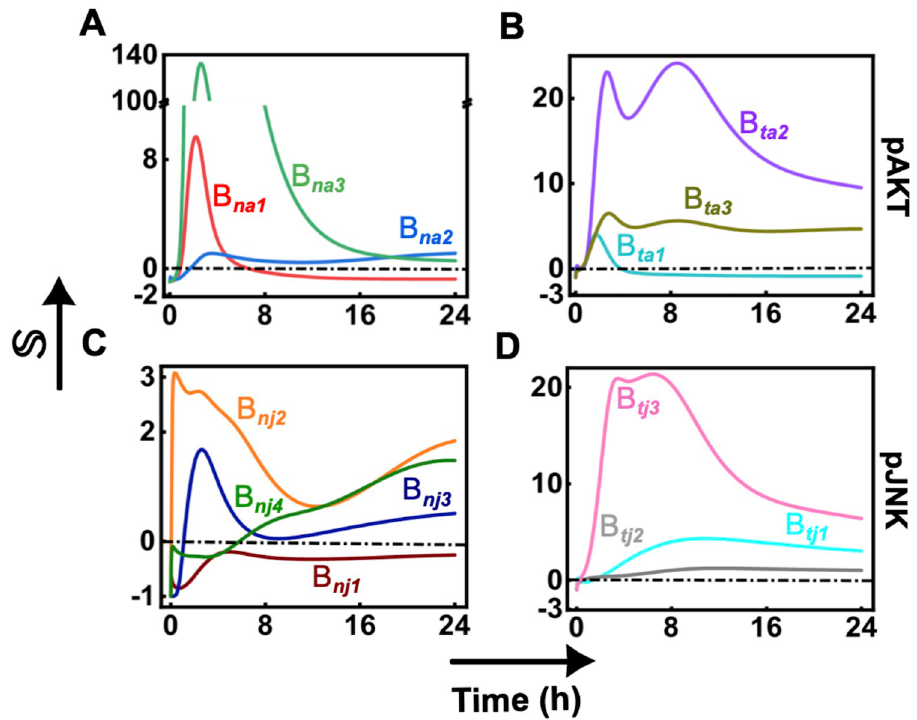
Fig 4. Dynamic evolution of the extent of synergism ( S , defined in Eq 3) facilitated by major branches as depicted in Table 1. Synergism ( S > 0 is positive and < 0 is negative) quantified from major branches originating from NF κ B to (A) pAKT and (B) pJNK, and that from TNFR1 to (B) pAKT and (D) pJNK. The evolution for other branches (S5 Table) are shown in S11